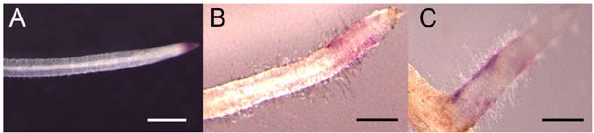
Figure 3. The extracellular part of SYM10 does not increase the recognition of non sulphated NF. nfp pMtENOD11:GUS roots untransformed (A) or transformed with pNFP:NFP-NFP (B), or pNFP:SYM10-NFP (C), 7 dpi with S. meliloti nodH . GUS activity is shown in magenta. Bars=500 m m. doi:10.1371/journal.pone.0026114.g003 PLoS ONE |